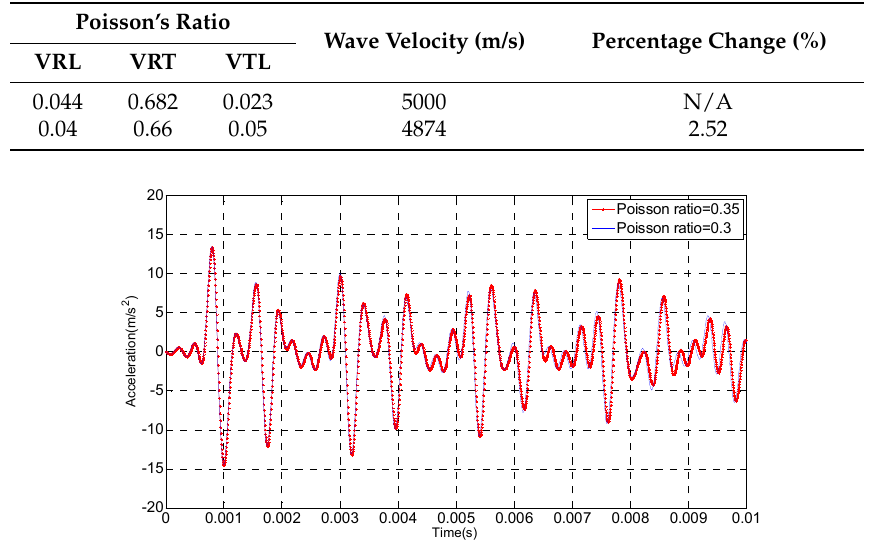
Table 9. Parametric study of Poison’s ratio for orthotropic model.